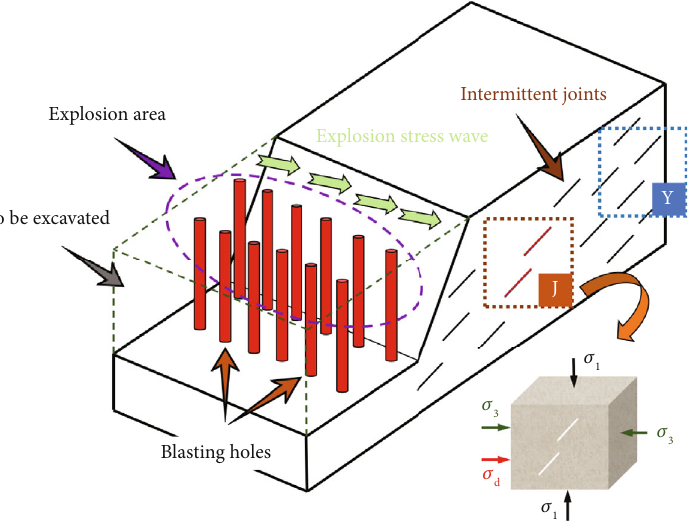
Figure 1: Sketch of mechanical models of “ key block ” in the slope with intermittent